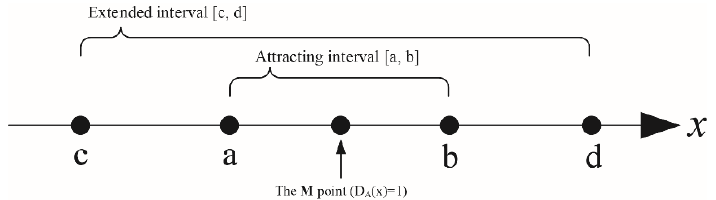
Figure 1. The position relation between random point 𝑥 and intervals [𝑎, 𝑏] and [𝑐, 𝑑] and point M.